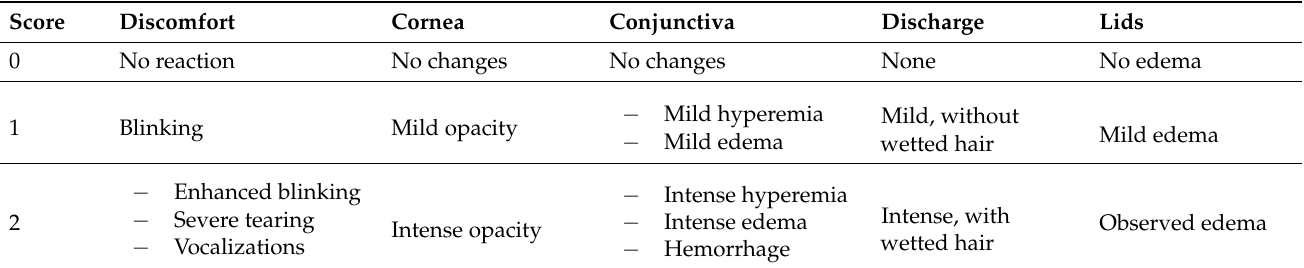
Table 3. The scoring system for ocular irritation testing (OECD